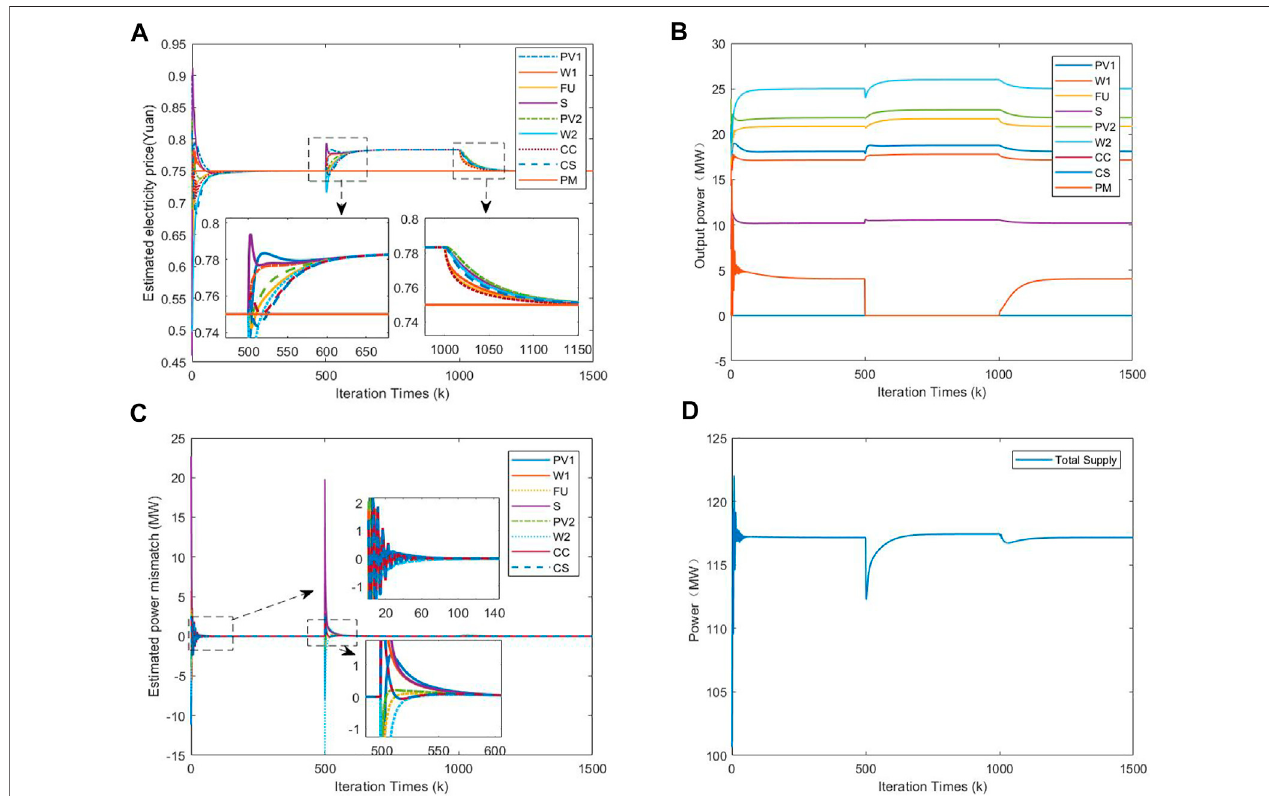
FIGURE 8 | Simulation results of “ grid-island-grid ” switching mode. (A) is the dynamic curve of the electricity price λ , (B) is the dynamic curve of the power output, (C) is the dynamic curve of estimated power, (D) is the dynamic curve of the total supply.